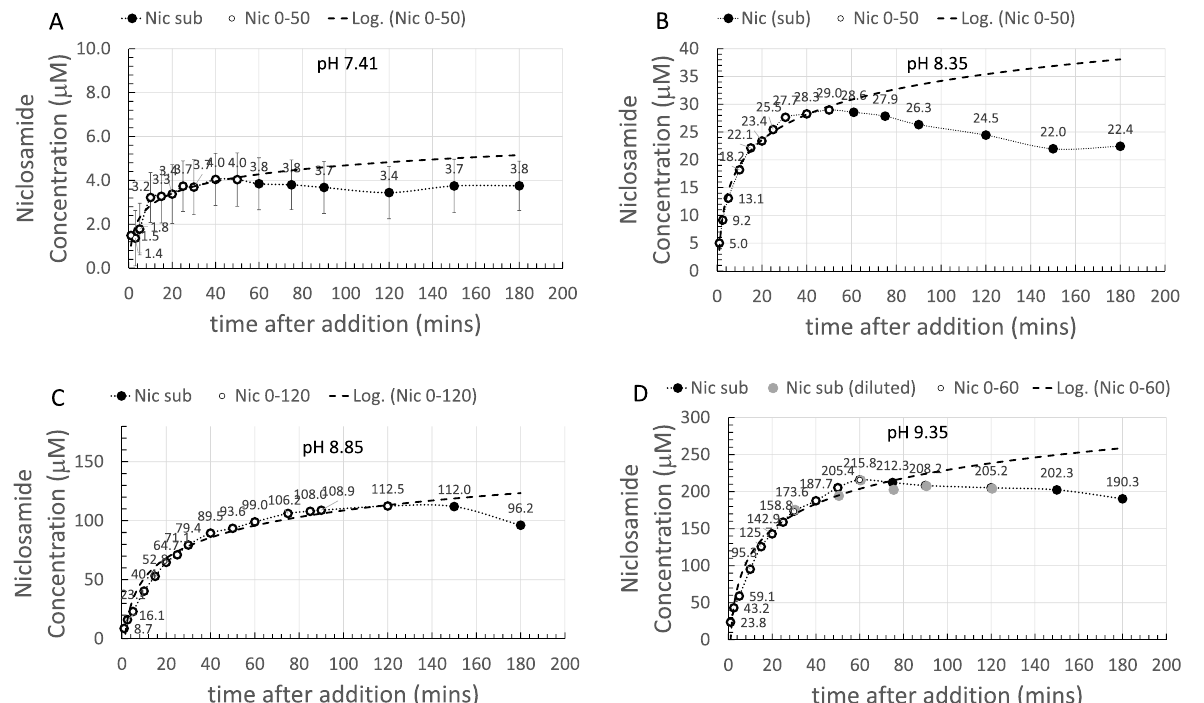
Fig. 9 Dissolution of Yomesan-niclosamide equivalent in Tris pH buffers (0–180 min, black-filled symbols): A 300 µM, niclosamide nominal pH 7.41, final pH 7.31; B nominal pH 8.35 final pH 8.25; C nominal pH 8.85, final pH 8.77; D nominal pH 9.35, final pH 9.27 (B, C, D are at 600 µM niclosamide); White symbols signify the data points used for the logarithmic fit (dashed lines) up to each peak time point of 50 min, 50 min, 120 min, and 60 min, respectively. Gray-filled symbols (pH 9.35) represent a 2 dilution as the niclosamide concentration increased and approached the limit × of detection for the UV-Vis absorbance detector. Error bars were ~ 1.5 µM and so within the filled symbols. The dotted line is to guide the eye and show the deviation from logarithmic. The day 2 concentration were 3 µM, 12.9 µM, 35.1 µM, and 112.3 µM (data not